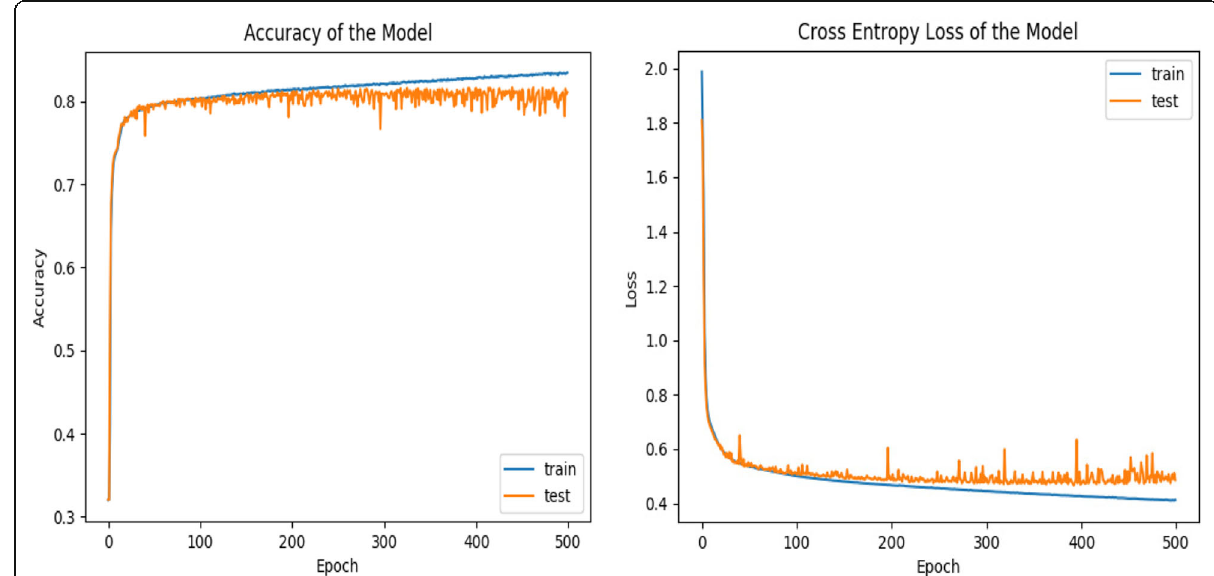
Fig. 5 Accuracy and Cross Entropy Loss of the Model for the UNSW_NB15